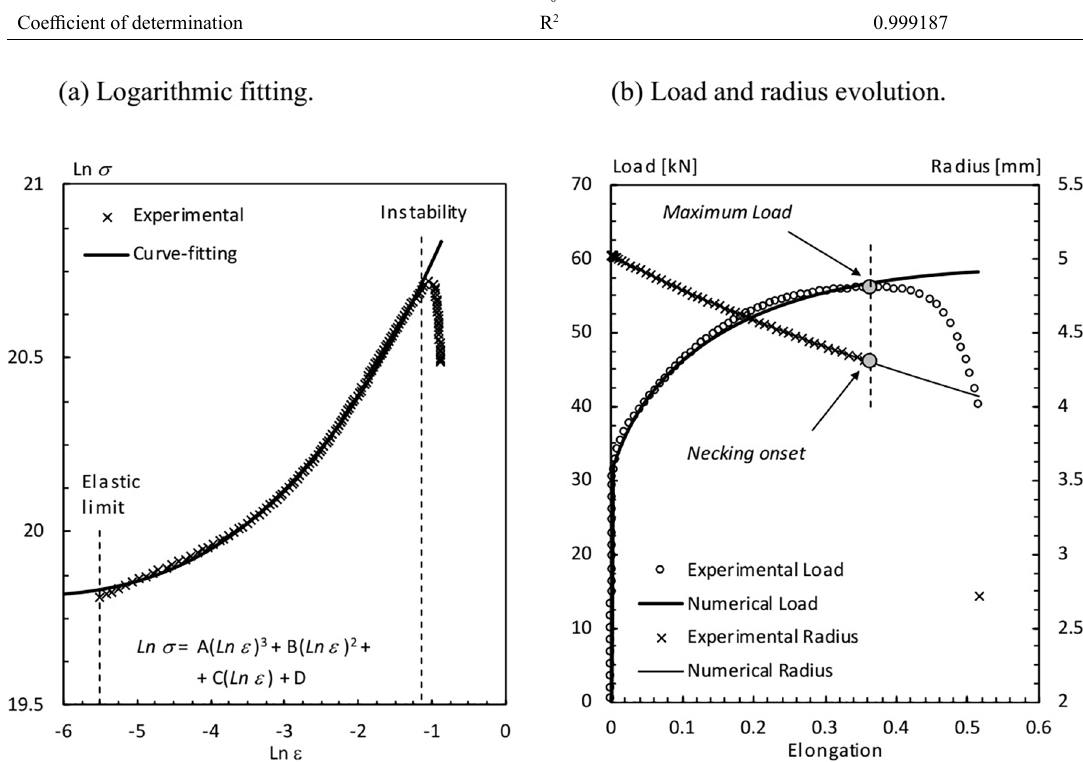
Figure 1. Third-order (ln σ ) × (ln ε ) logarithmic curve: (a) Fitting of the third-order equation and (b) evolution of the tensile load and specimen central